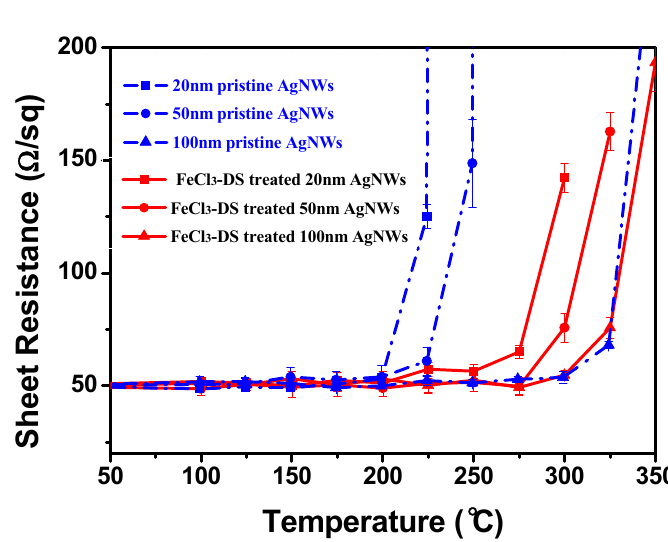
Figure 5. Sheet resistance variation of AgNW TCFs of AgNWs with different diameters in the thermal test: pristine AgNWs (blue lines) and 60 min FeCl 3 -DS treated AgNWs (red lines).